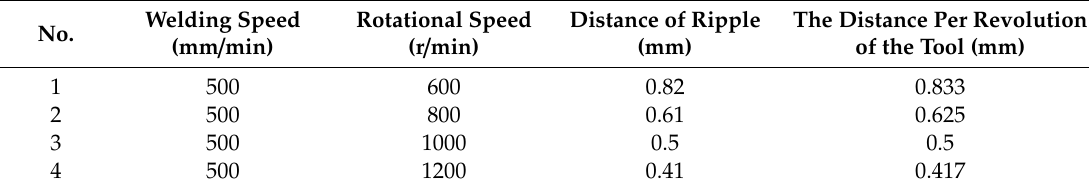
Figure 5. Macromorphology of the weld surface at different rotational speeds. Table 2. The distance of the weld ripple at different rotational speeds.